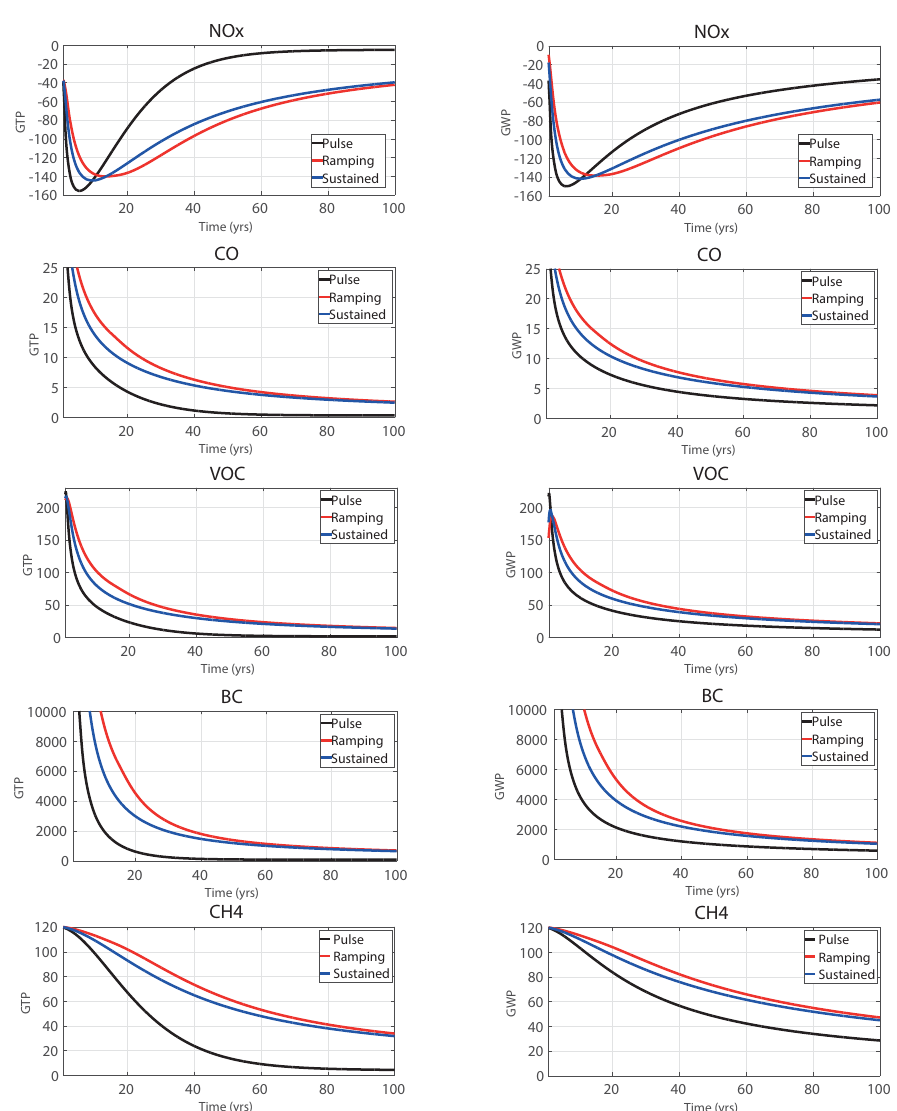
Figure 9. The emission metric values for different types of emission profiles for European emissions in summer, with GTP to the left and GWP to the right. The ramping period is set to 15 years. We include NO x , CO, and VOCs (top) as ozone precursors that include processes that alter the atmospheric chemistry on both monthly and yearly scales and BC (middle) representing particle emissions with an atmospheric lifetime of about a week. To put this into perspective, we also show CH 4 (bottom), which perturbs the atmosphere with a lifetime of roughly 12